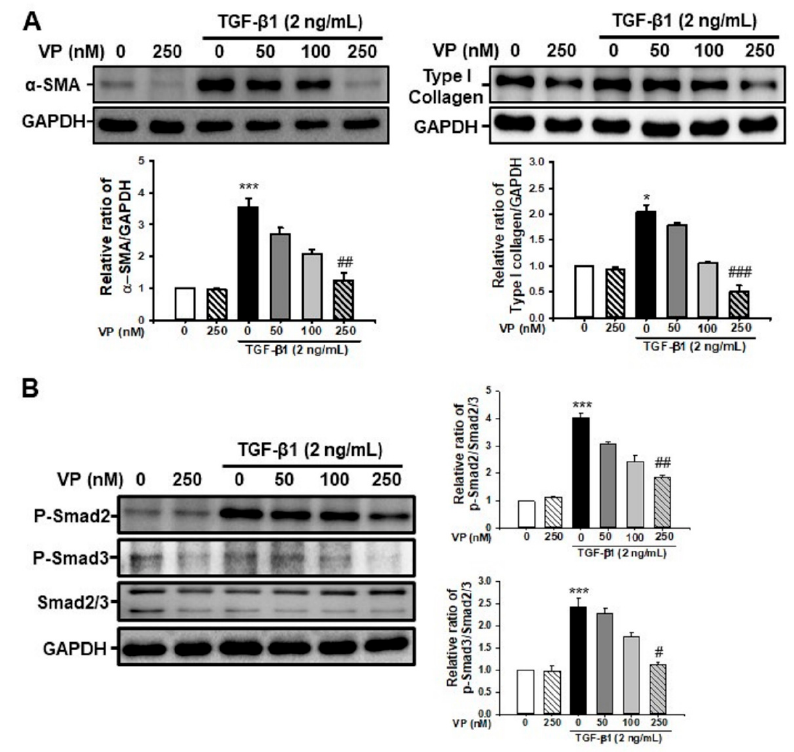
Figure 6. Effect of verteporfin on TGF-ß1-induced α -SMA and type I collagen through the regulation of the TGF- β 1/Smad signaling pathway in NRK-49F cells. ( A ) Representative Western blot for α -SMA and type I collagen from NRK-49F cells treated with vehicle (Veh) or TGF- β 1 (2 ng/mL) with or without verteporfin (VP) at the indicated doses (50, 100 and 250 nM). Treatment with TGF- β 1 (2 ng/mL) for 24 h increased the expression of fibrotic markers. The expression of α -SMA and type I collagen decreased dose-dependently after VP treatment. The bar graph shows the densitometric quantification as the relative ratio of each protein to GAPDH. Data are presented as the mean ± SD. ( B ) Representative Western blot for phospho-Smad2 and phospho-Smad3 expression from NRK-49F cells treated with vehicle (Veh) or TGF- β 1 (2 ng/mL), with or without VP at the indicated doses (50, 100, and 250 nM). TGF- β 1 (2 ng/mL) treatment for 30 min increased the expression of phospho-Smad2 and phospho-Smad3, and VP treatment dose-dependently decreased that increase. The densitometric measurement of phospho-Smad2 and phospho-Smad3 protein expression is presented as the Smad2 / 3 protein expression ratio. The data are represented as the mean ± SD. *** p < 0.001 versus Veh or VP; # p < 0.05, ## p < 0.01 versus TGF- β 1 treatment. Veh, vehicle; VP, verteporfin; TGF- β 1, transforming growth factor- β 1; α -SMA, α -smooth muscle actin; GAPDH, glyceraldehyde 3-phosphate